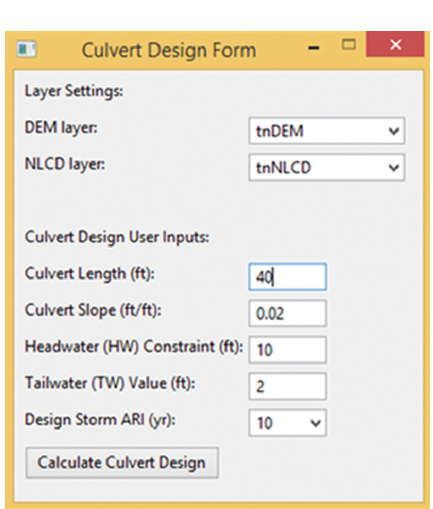
Figure 2: Culvert design user interface